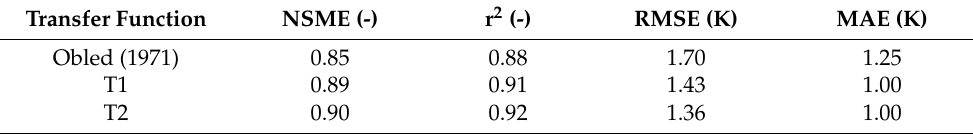
Table 4. Comparison of mean efficiency criteria for air temperature transfer functions.